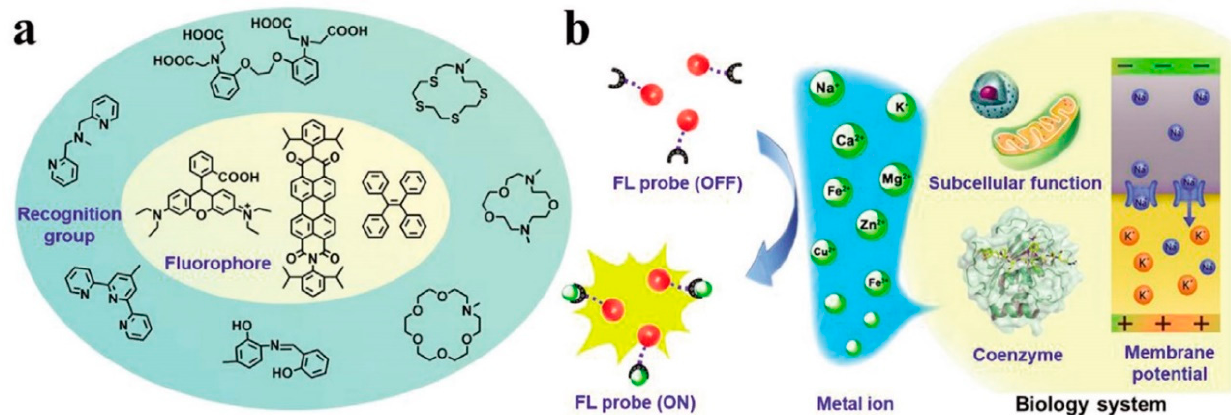
Figure 2. Schematic illustration of ( a ) the composition and sensing mechanism and ( b ) biological applications of metal ions probe. Reprint from [25] under Creative Commons Attribution 4.0 International License.